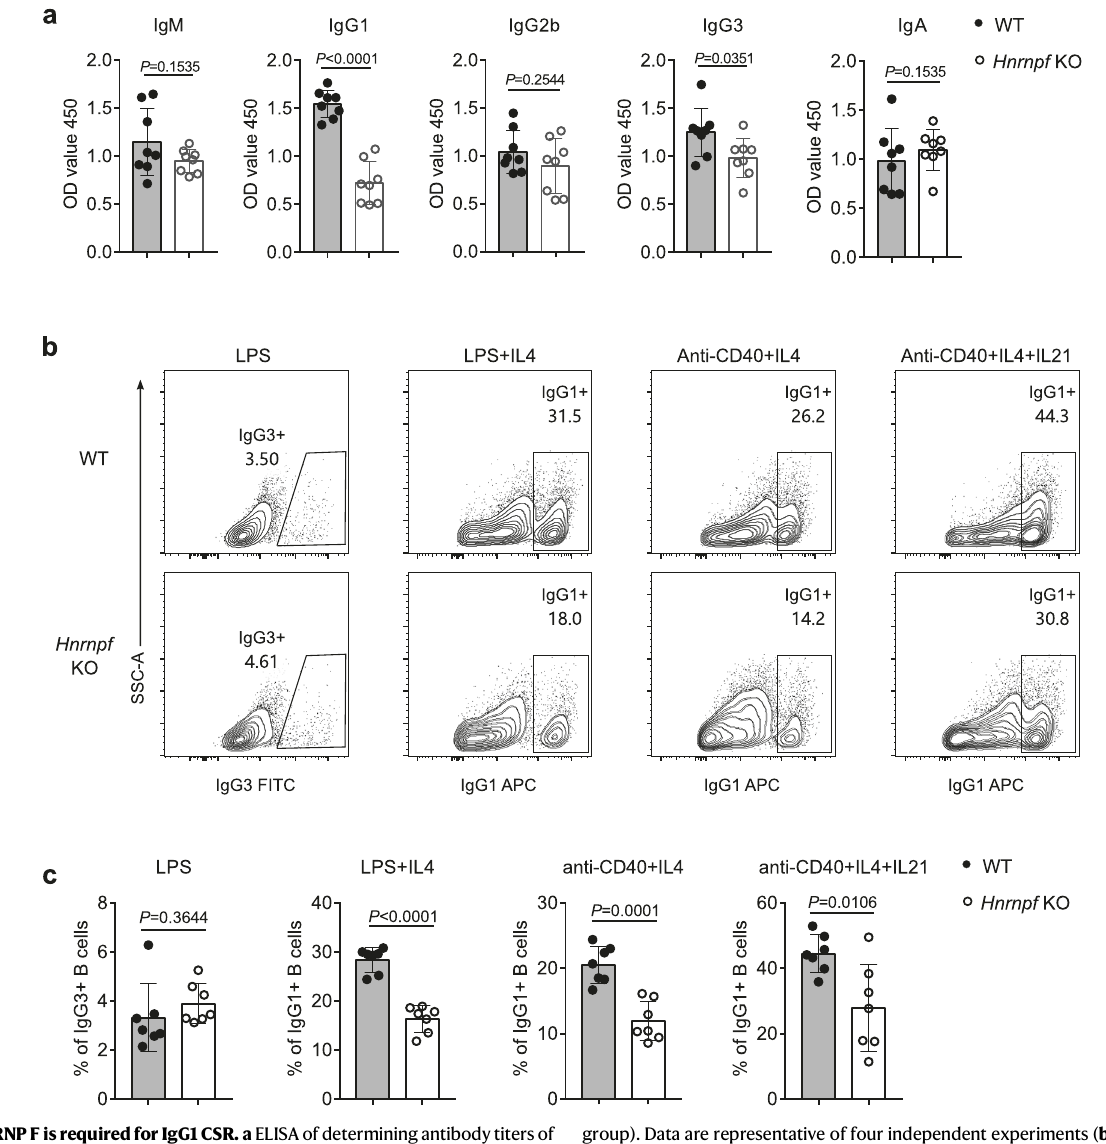
Fig.3|hnRNPFisrequiredforIgG1CSR.a ELISAofdeterminingantibodytitersof totalIgM,IgG1,IgG2b,IgG3,andIgAinseraofunimmunizedWT( n =8)and Hnrnpf KO ( n =8) mice. Data are from one single experiment. b , c Flow cytometry mea- suring CSR to IgG3 or IgG1 in activated B cells with indicated stimulation ( n =7